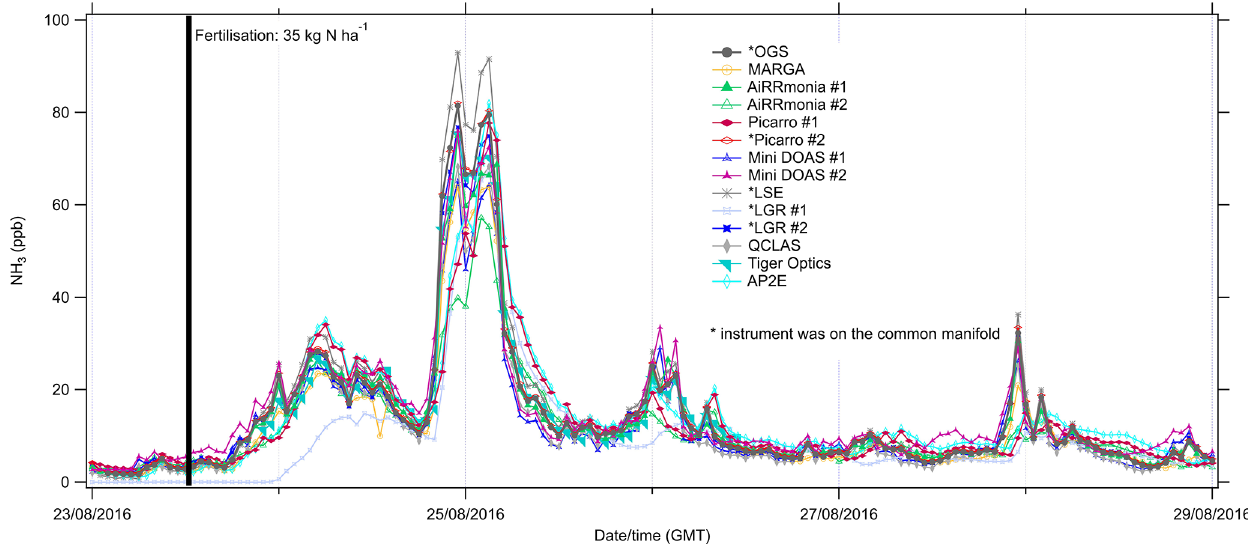
Figure 5. Time series of hourly averages from 23 to 29 August 2016 of NH 3 measurements at Easter Bush. The shaded area is the period of fertilisation using urea.